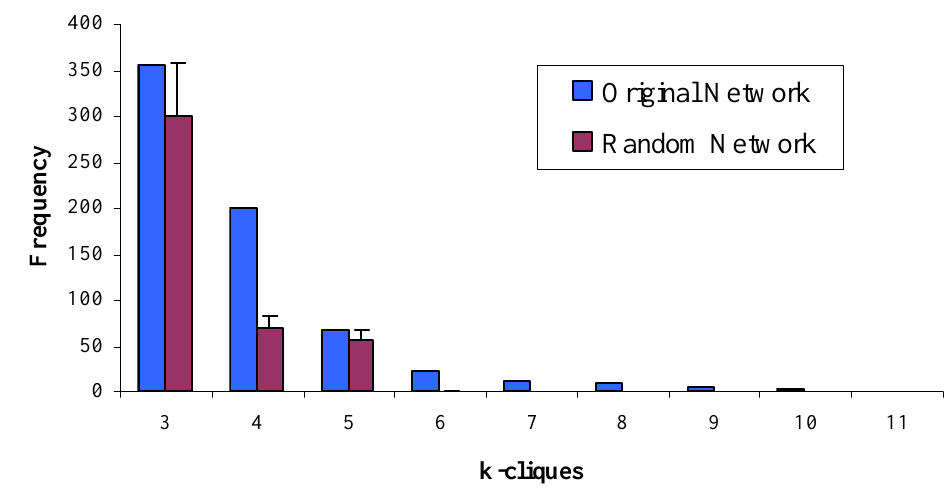
Figure 1: Identification of k -clique communities. The number of identified k -clique communities is shown for the original and random